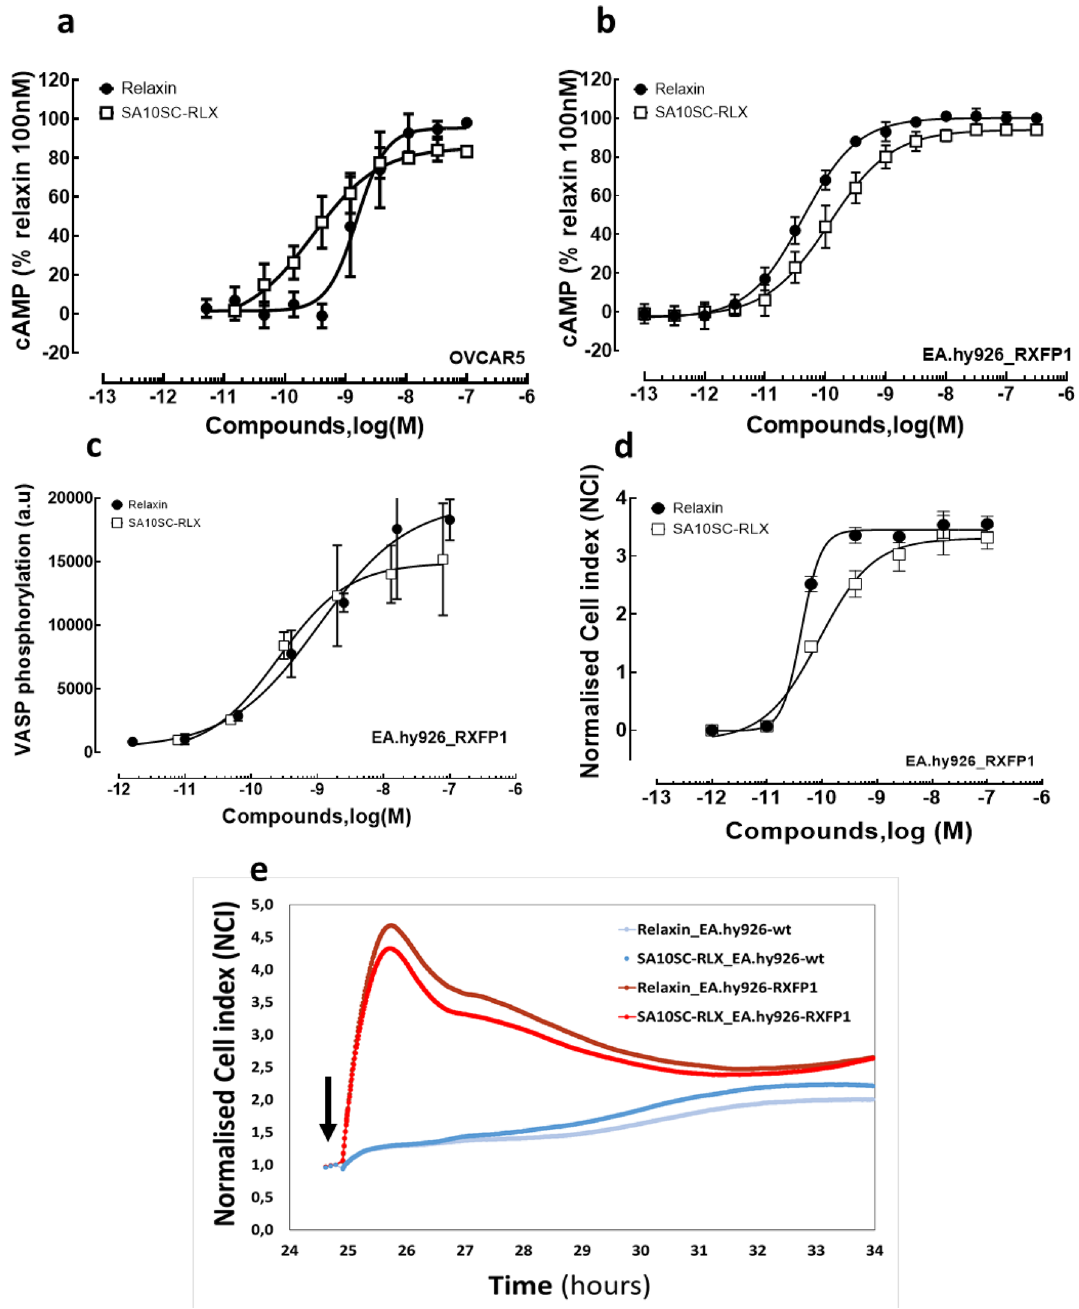
Figure 2. SA10SC-RLX and RXFP1 signaling. Concentration-dependent increases in cAMP induced by relaxin or SA10SC-RLX in human OVCAR5 cells expressing endogenous RXFP1 ( a ) (mean ± SEM, n = 6 different experiments performed in triplicate) or in EA.hy926_RXFP1 cells ( b ) (mean ± SEM, n = 5 different experiments performed in triplicate). Concentration dependent increases in VASP phosphorylation induced by relaxin or SA10SC-RLX or EA.hy926_RXFP1 cells (one representative experiment performed in duplicate out of 3) ( c ). Concentration dependent RXFP1 activation by relaxin or SA10SC-RLX recorded by real time impedance measurements (Xcelligence, CNI) in EA.hy926_RXFP1 (one representative experiment performed in duplicate out of 3) ( d ). Real time impedance trace over a period of 10 h after treatment with 10 nM relaxin or 10 nM SA10SC-RLX in wt EA.hy926 cells (blue lines) or EA.hy926_RXFP1 (red and orange lines) (one representative trace out of 3 different experiments) The arrow indicates the injection of the compounds ( e